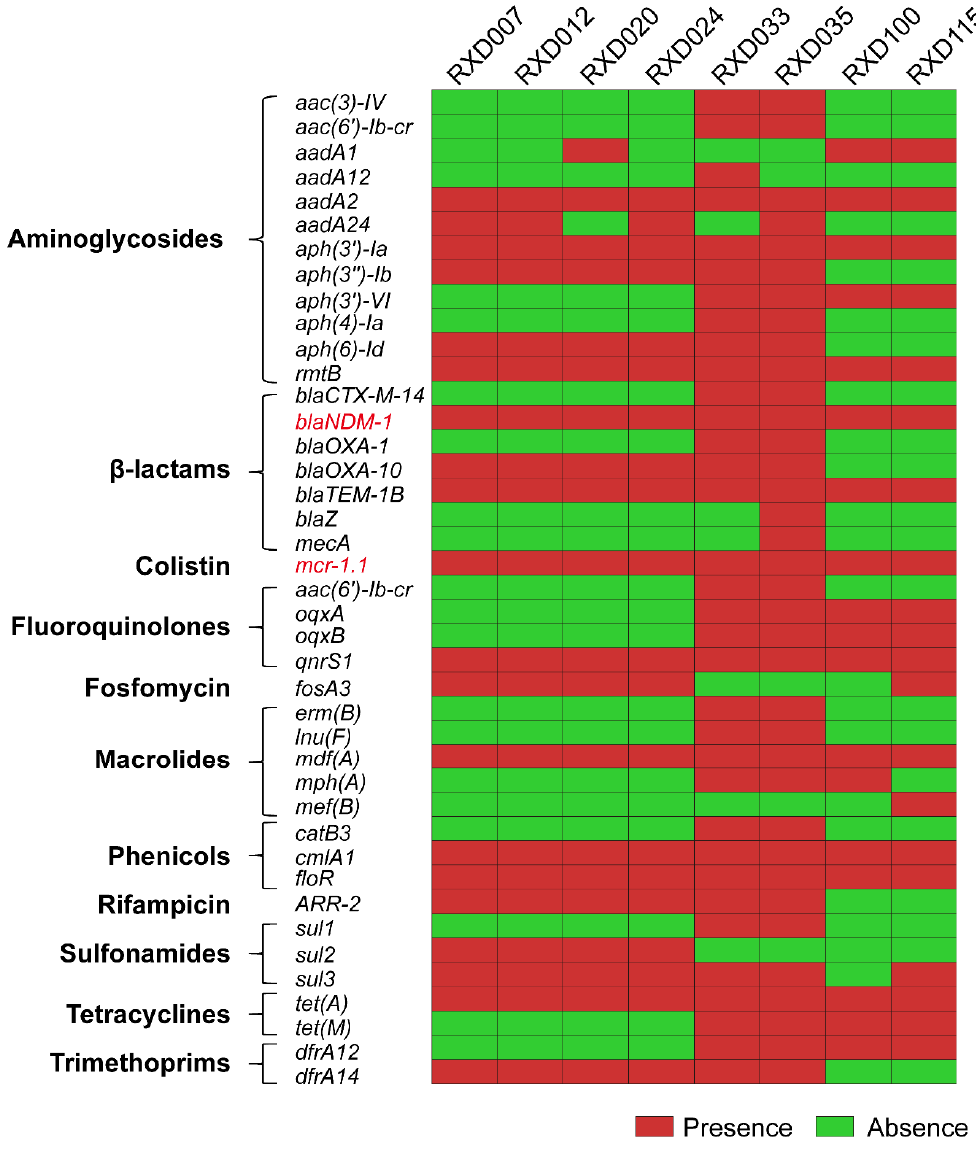
Figure 3 . Heatmap showing acquired resistant genes identified in each of the eight carbapenem- resistant and colistin-resistant E. coli